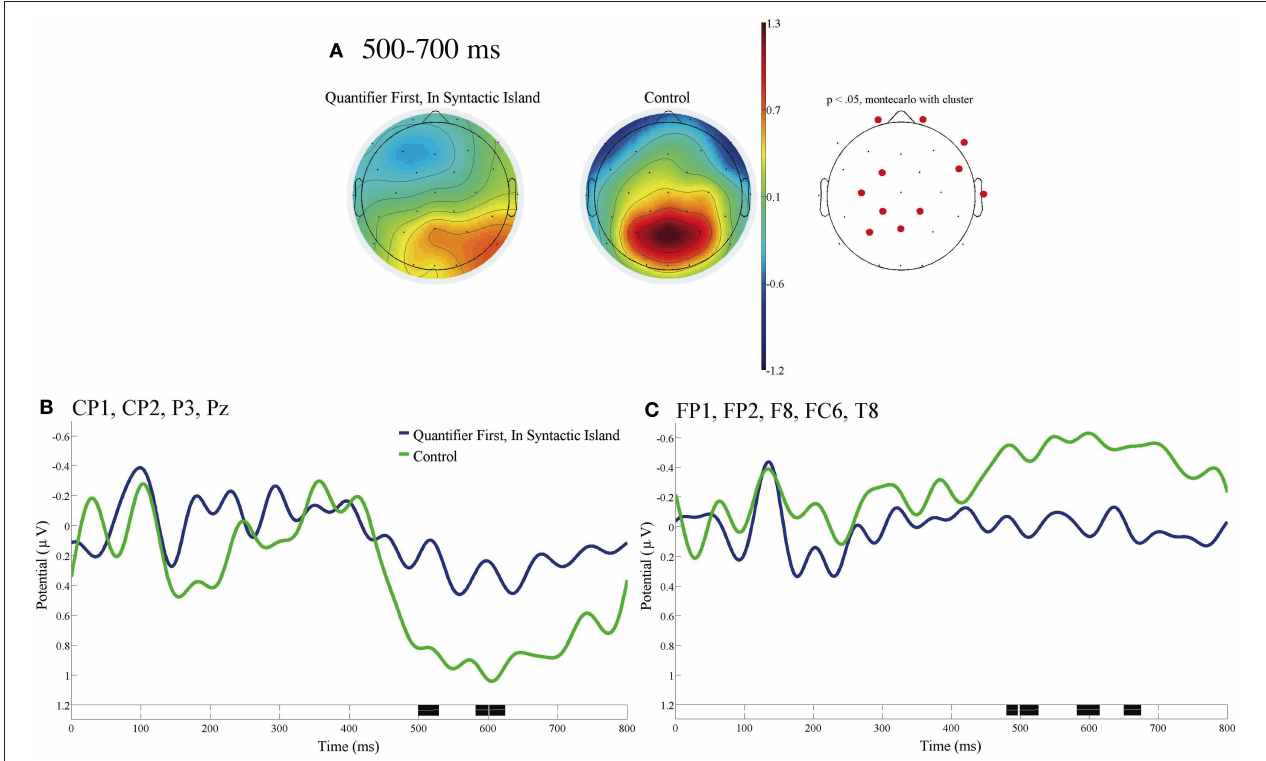
FIGURE 5 | ERPs time-locked to the onsets of the subordinate verbs of Quantifier First and the control in (A–C) with the baseline from 0 to 100 ms. (A) Mean topographies of the ERPs from 500 to 700 ms for the In Syntactic Island (left) and the control (right) conditions; the electrode sites at which significant differences were found using the cluster-based permutation test ( p < 0.05) are depicted in red. (B) Mean ERPs of the two conditions at the centro-parietal electrodes (CP1, CP2, P3, and Pz), and (C) Mean ERPs of the two conditions at the right frontal electrodes (FP1, FP2, F8, FC6, and T8). Negativity is plotted upward, and the time windows during which significant differences were found by the cluster-based permutation test are indicated in black on the time axes in (B,C)